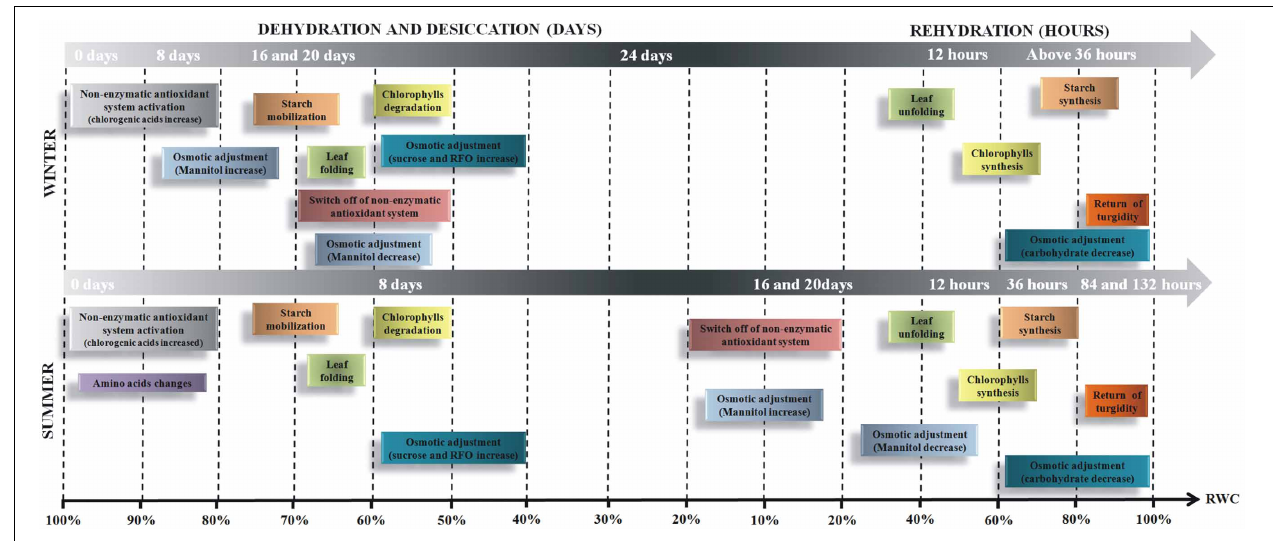
FIGURE 8 | Schematic representation of changes in metabolism during dehydration and rehydration in Barbacenia purpurea plants. The time-dependent events observed in B. purpurea plants cultivated and submitted to extreme water deficit during winter and summer